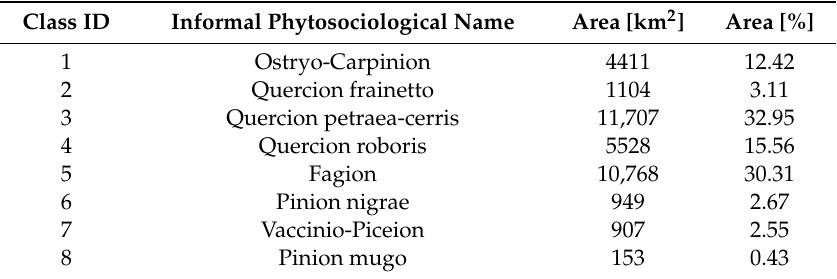
Table 4. Area and share in the total forest area for each woody vegetation class after classification using the MC rule and 5 × 5 neighborhood for